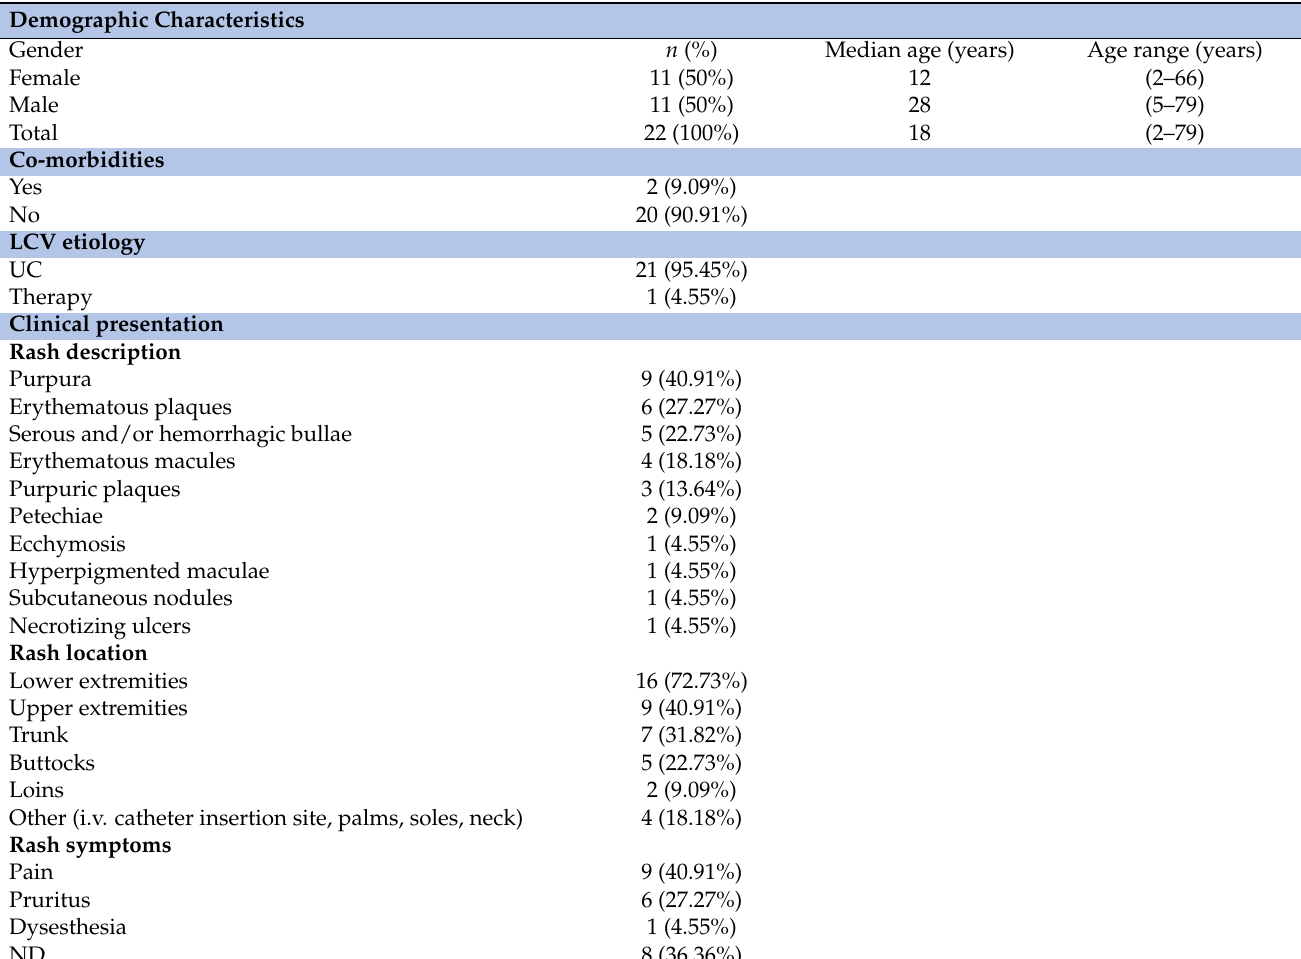
Table 1. The epidemiology, demographics, clinical presentation, diagnostic findings, and outcome in LCV in UC